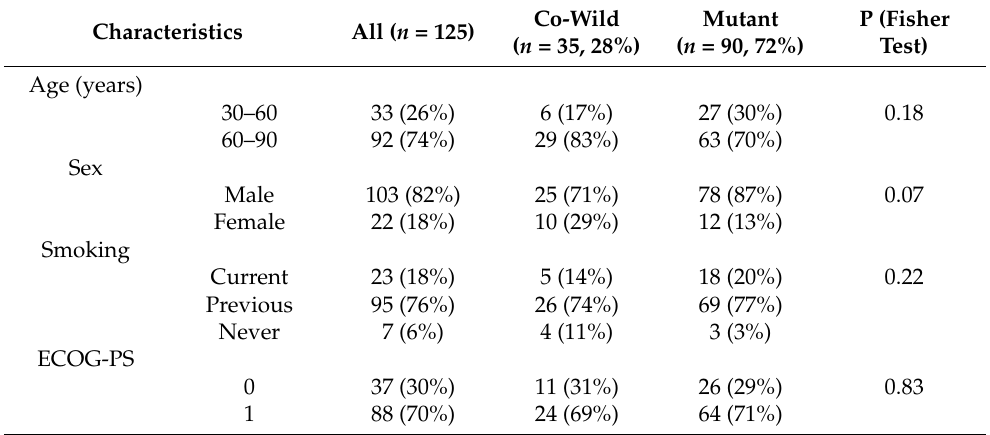
Table 1. Clinical characteristics of the 125 patients with LUSC in the POPLAR/OAK